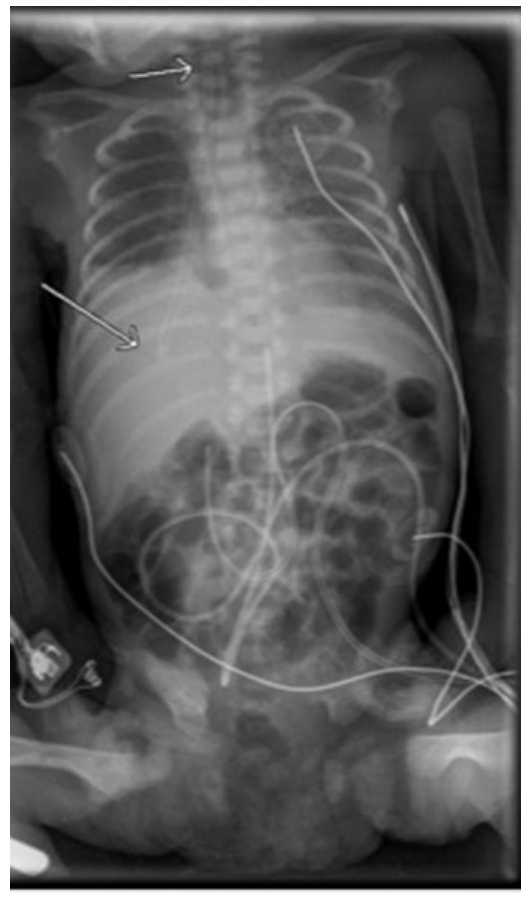
Fig. 1 Chest X-ray. Arrow on chest computed tomography indicates the proximal and distal tips of foreign body.